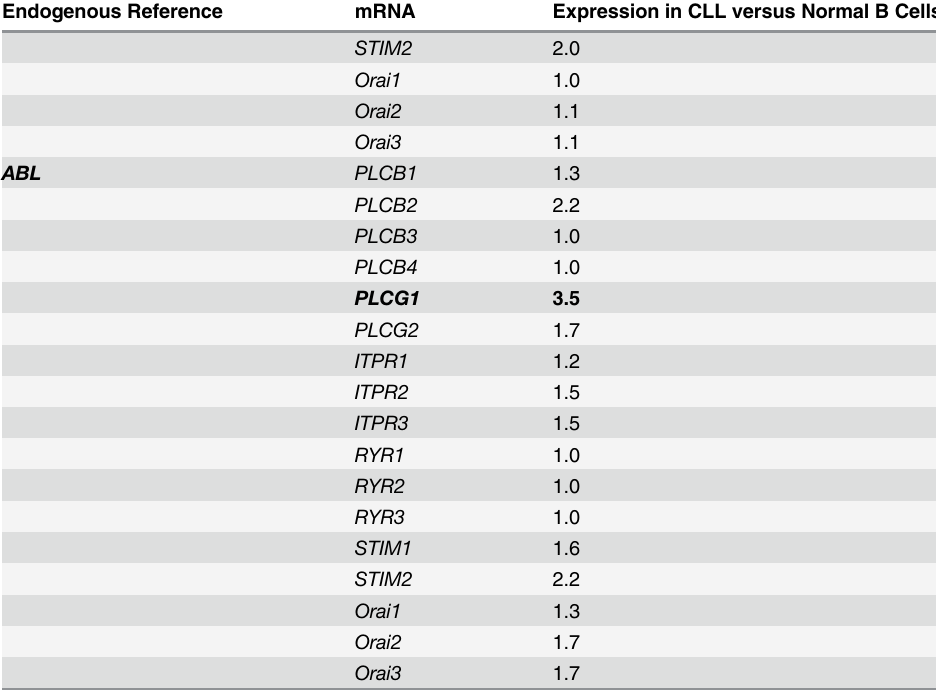
Quantitative RT-PCR was performed on B cells from 11 healthy donors and 50 representative CLL patients (Binet Stage A, n = 30; Binet Stage B/C, n = 20; fi ve samples with dysfunctional TP53 ). Expression values indicate the mean value obtained for transcripts in CLL cells related to the mean value obtained for the same transcripts in normal B lymphocytes. Data were analyzed using the comparative threshold cycle method. The amount of cDNA measured is normalized to the endogenous references GUSB or ABL (see Methods for gene details). PLCG1 is given in